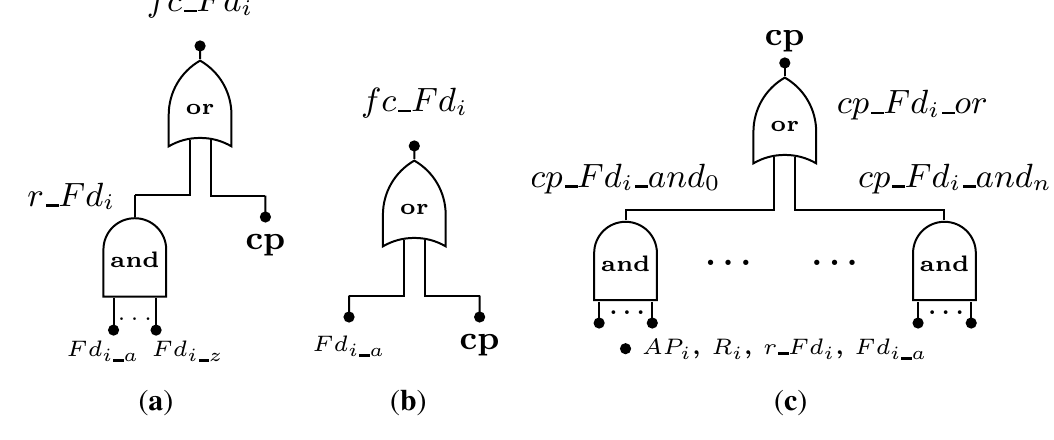
Figure 7. Device failure condition. ( a ) Redundant field device; ( b ) Simple field device; ( c ) Connectivity